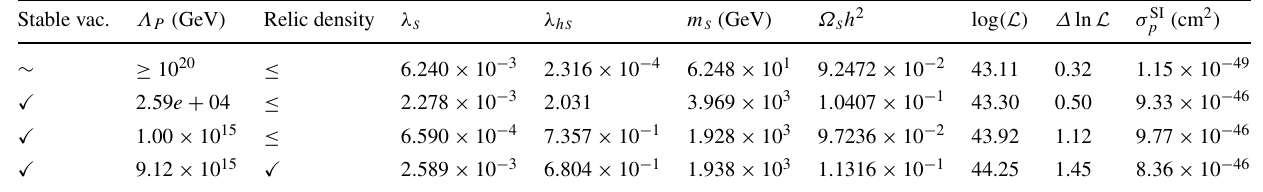
of the Planck observed value ( Ω S h 2 ∼ Ω DM h 2 ) are indicated with a tick in the third column. We omit the values of the nuisance parame- ters, as they are not significantly different to the central values of their respective likelihood functions